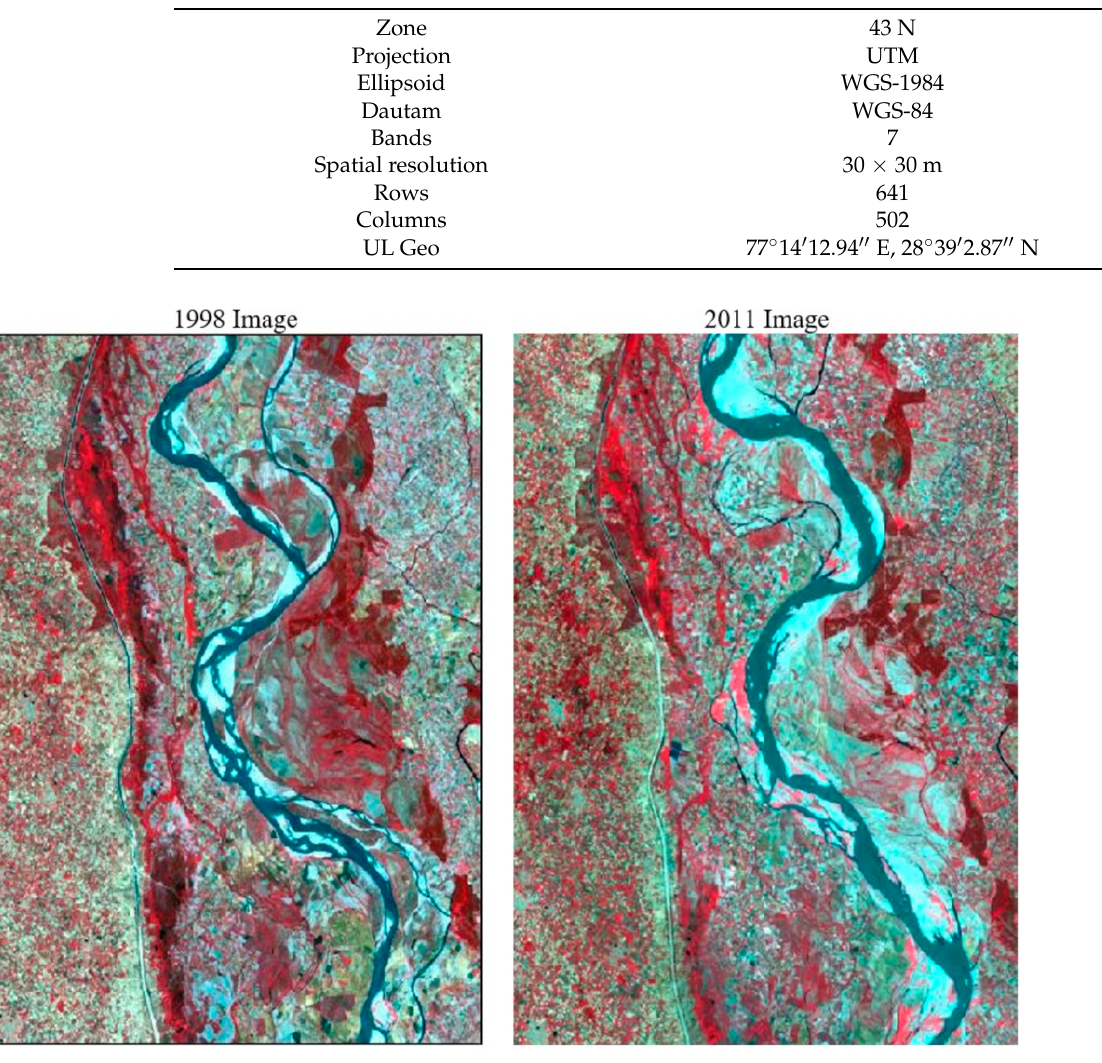
Figure 6. Landsat Images of Delhi